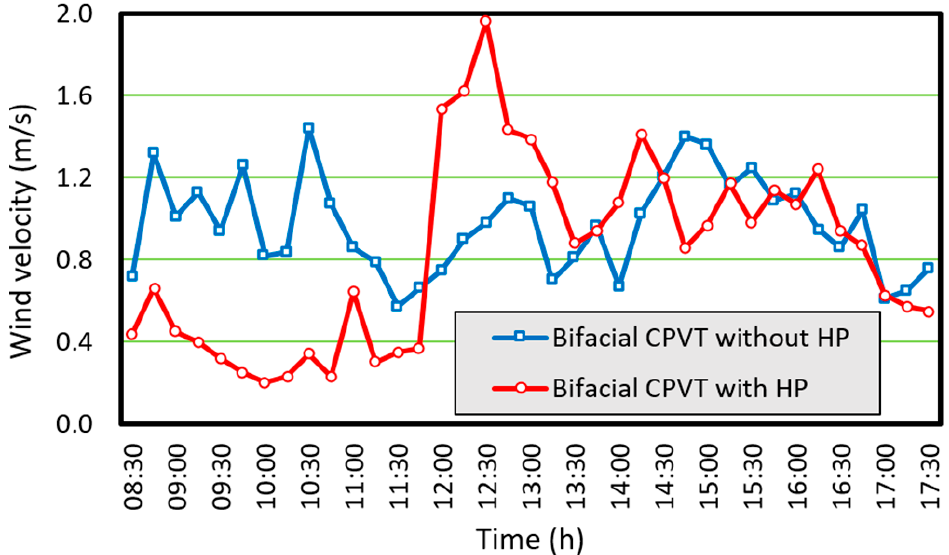
Figure 5. Change in the wind velocity for the bifacial CPVT systems with and without HP.